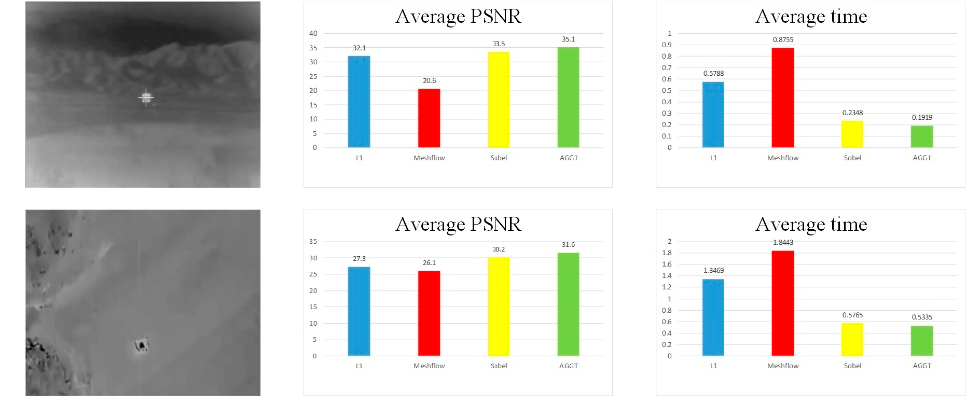
Figure 8. Comparison of two metrics.